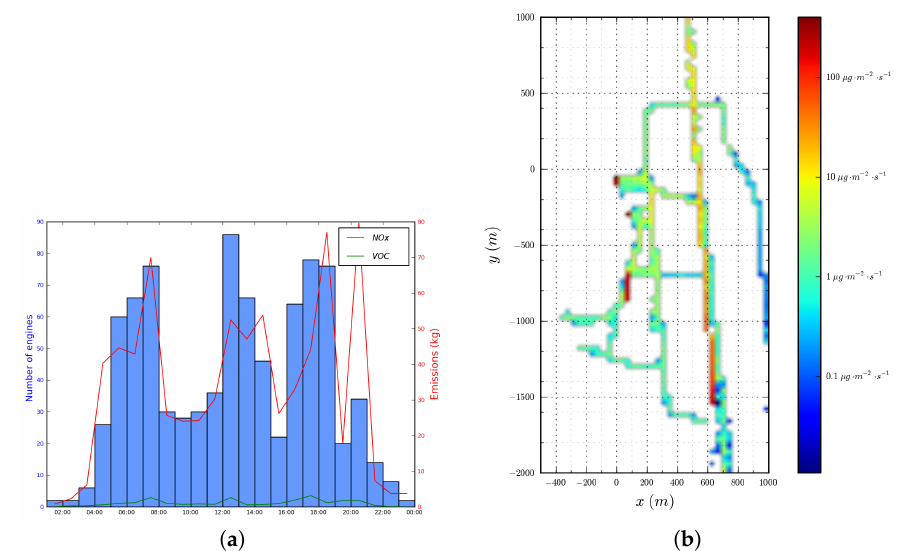
Figure 1. ( a ) NO x and Volatile Organic Compound (VOC) emissions time series with hourly engines aircraft activities; ( b ) Cumulated surface flux of NO x emissions ( µ g/m 2 /s) on 10 September